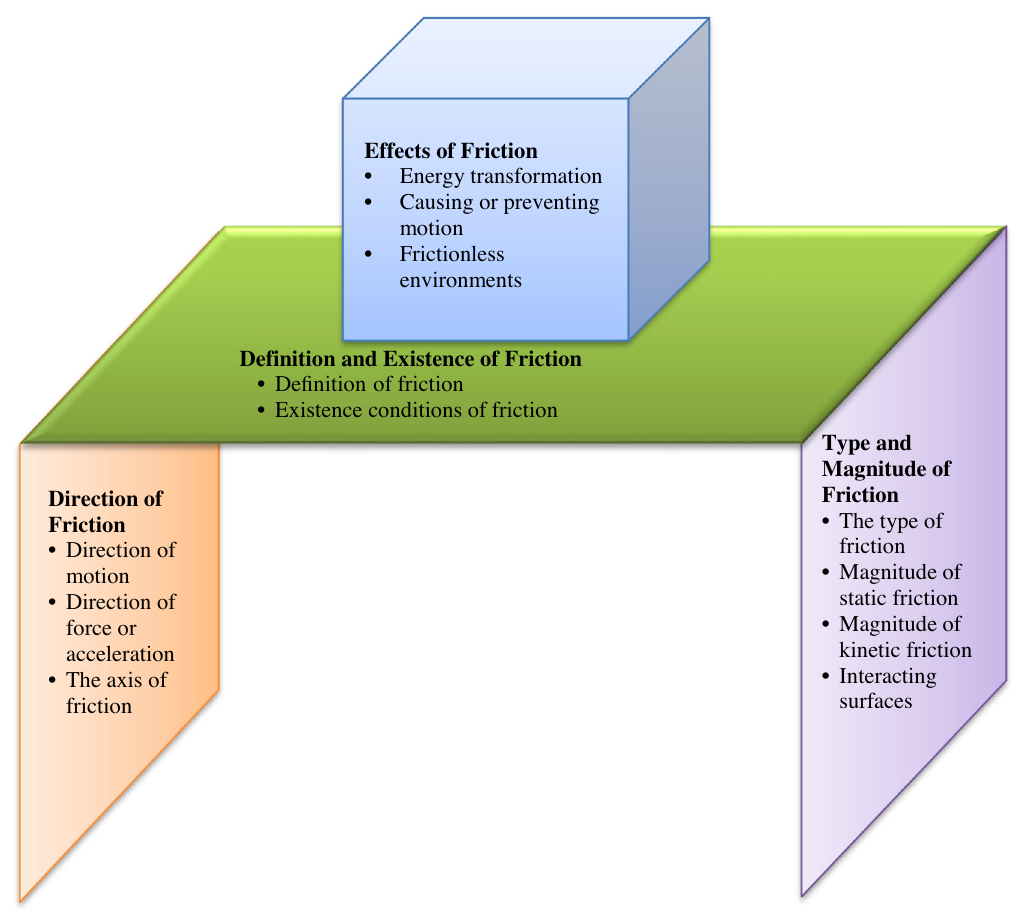
FIG. 1. Desk analogy of PMC